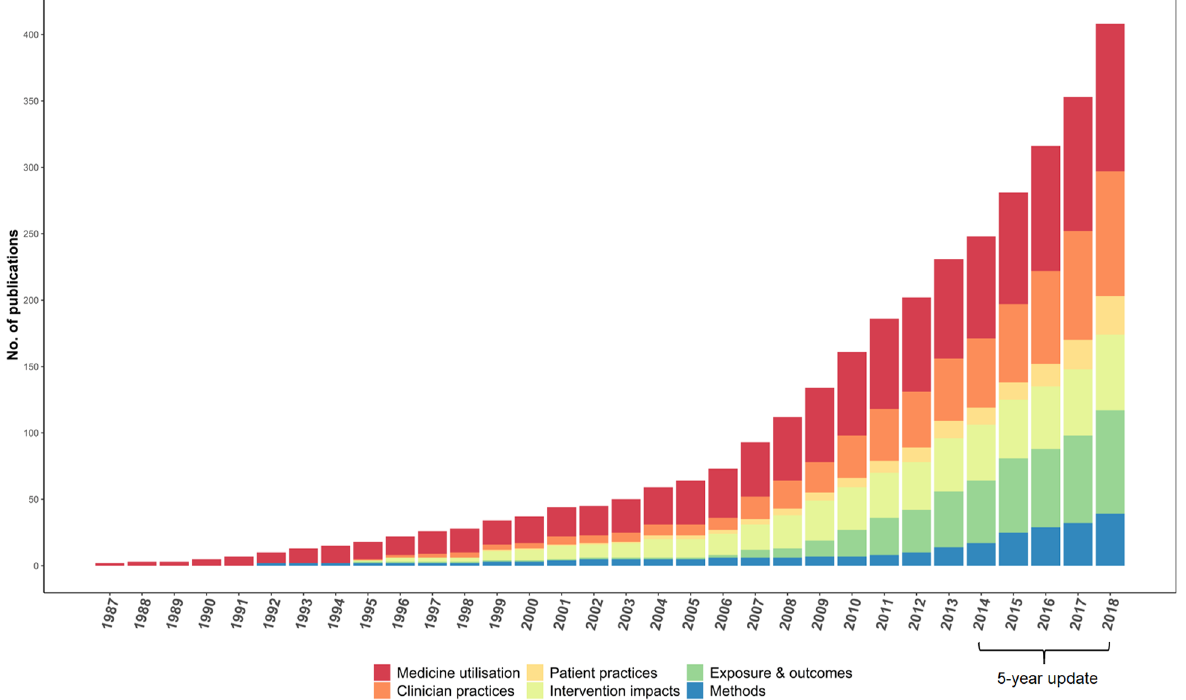
Supplementary Figure 3: Number of publications (cumulative) according to study focus